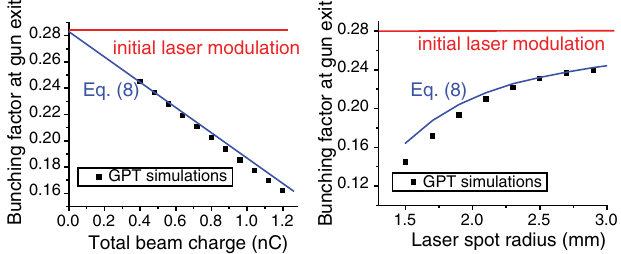
FIG. 6. Bunching factor at the gun exit as a function of laser input parameters and beam charge.